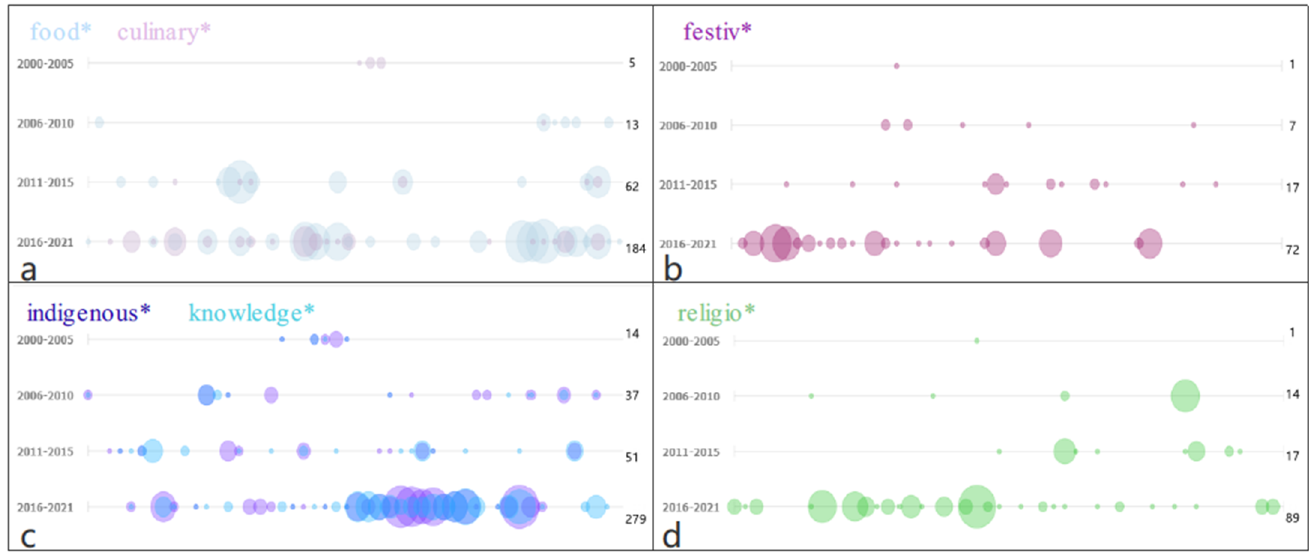
Figure 6. ( a ) Bubblelines of culinary tourism. ( b ) Bubblelines of festival tourism. ( c ) Bubblelines of ecotourism. ( d ) Bubblelines of religious tourism. Note: * means match terms that start with this word as one term. Source: edited by authors based on research and Voyant Tools output.